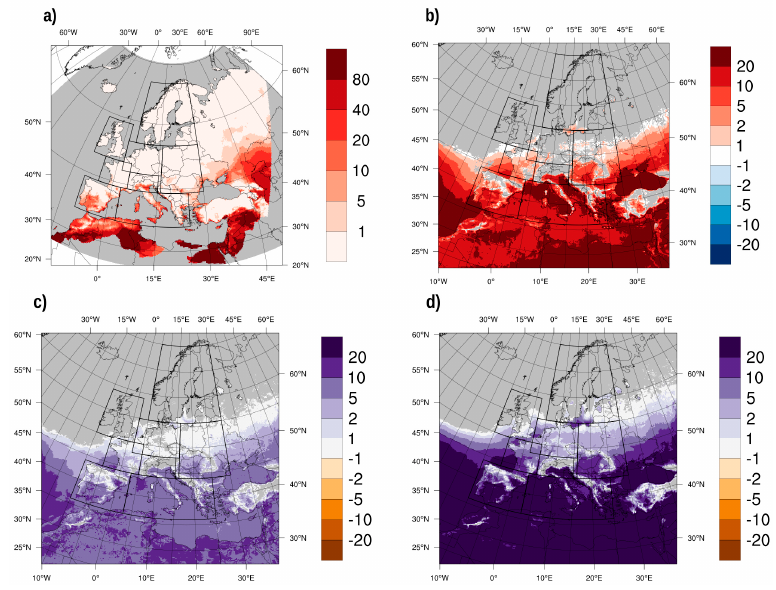
Figure 2. Same as Figure 1, but for tropical nights in days per year.